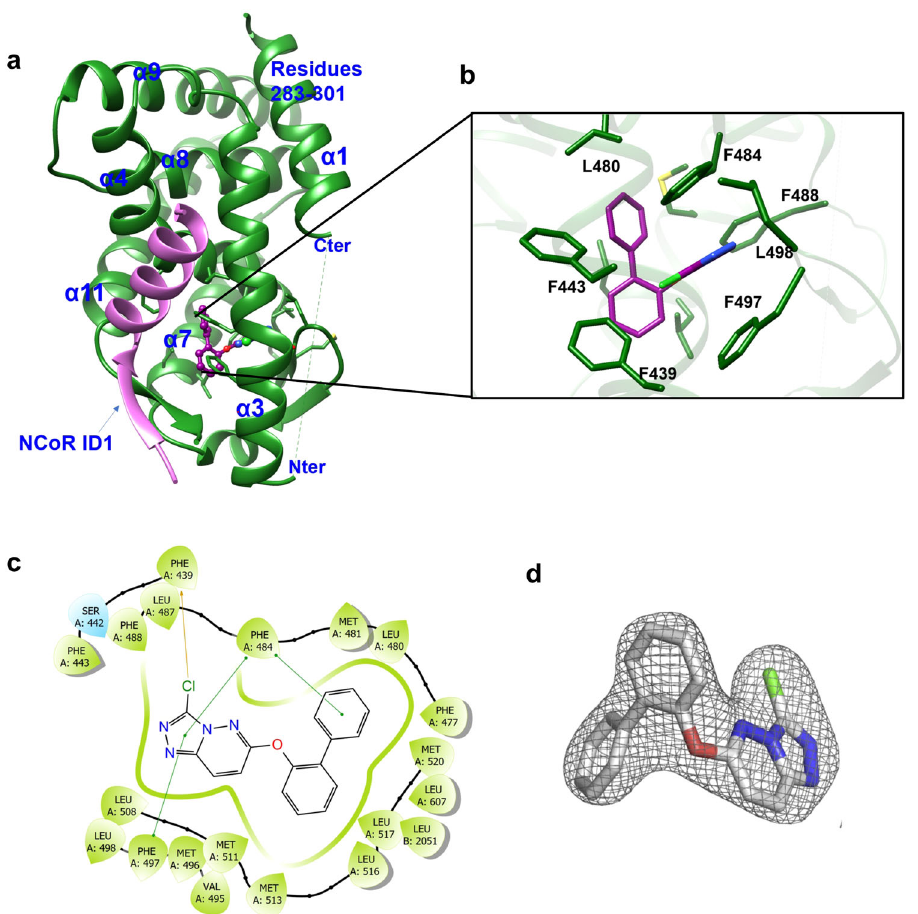
Fig. 3 | Crystal structure of STL1267 bound to the ligand binding domain of REV-ERB α . a Crystal structure of STL1267 bound to the ligand binding domain of REV-ERB α withNCoRID1. REV-ERB α is illustrated ingreen ribbonsand NCoR ID1in purple ribbons. The ligand is shown as ball and stick representation. Common structural components ( α helices) within the nuclearreceptor LBD are designated. b Close-up view of STL1267 binding within the ligand binding pocketof REV-ERB α . The ligand is illustrated as purple stick representation and the protein amino side